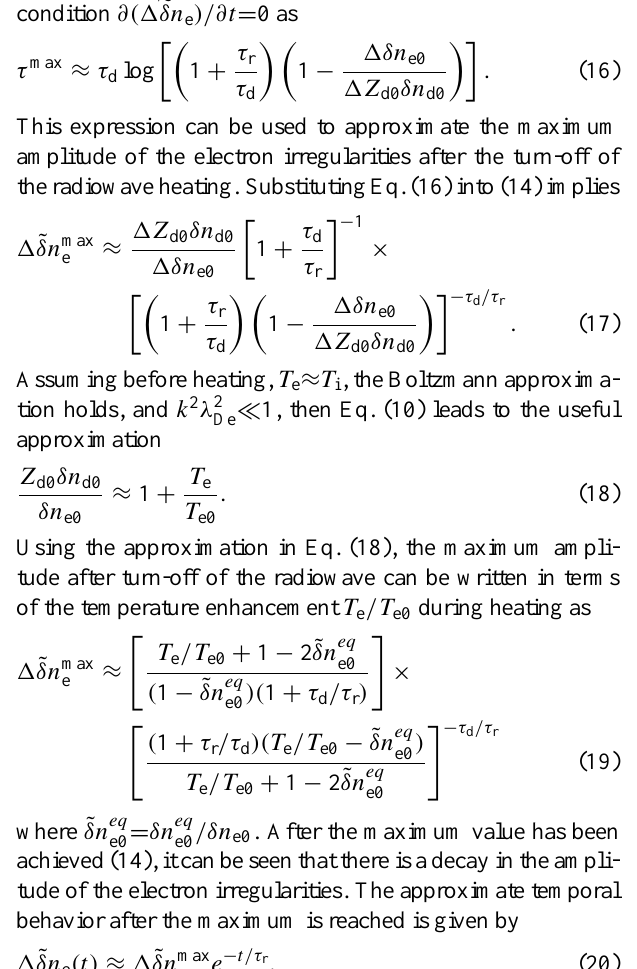
Fig. 4. Comparison of the full computational model of Sect. 2.1 with the analytical model (Eq. 14) for the parameters of Fig. 1. Note results represented in the form of 1 ˜ δn e which is the normal- ized electron irregularity amplitude difference from the equilibrium before